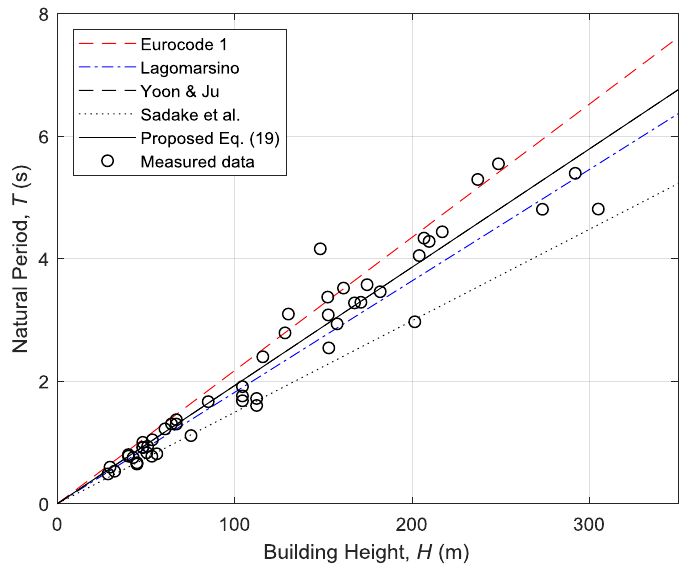
Figure 9. Comparison of proposed equation for natural frequency estimation with other empirical formulae.